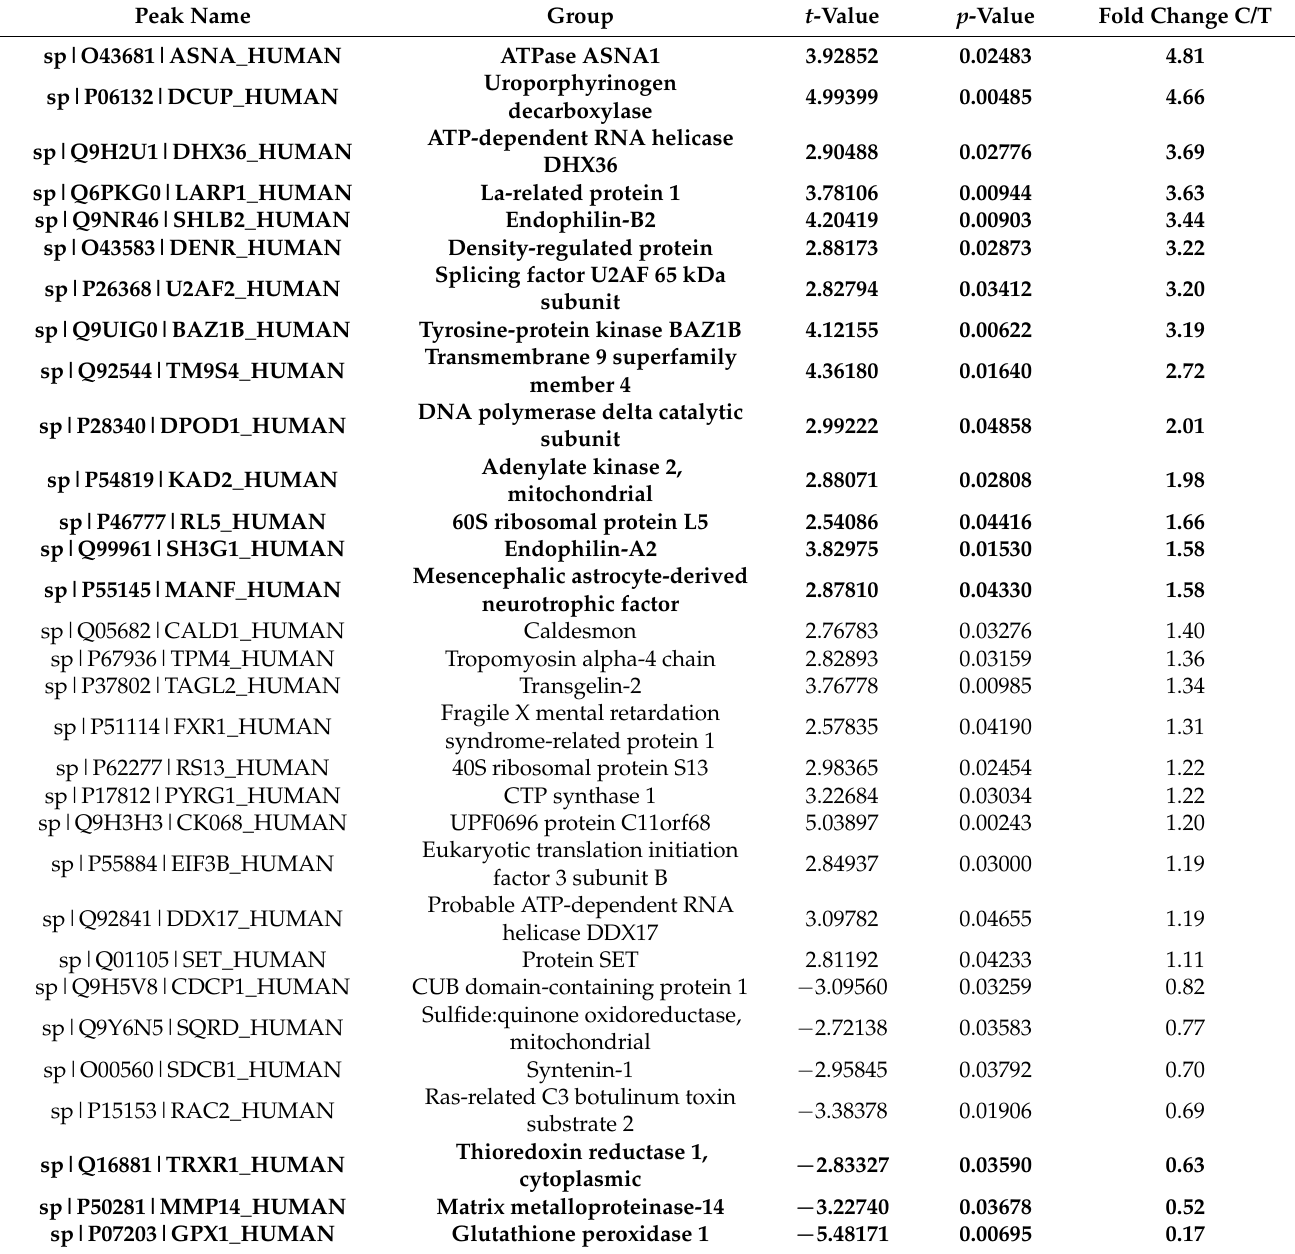
Table 2. Differentially expressed proteins identified by SWATHS analysis in MDA-MB-231 TNBC cells treated (T) or not (C) with TcPaSK peptide. Shown in bold are proteins exhibiting ≥ 1.5-fold change